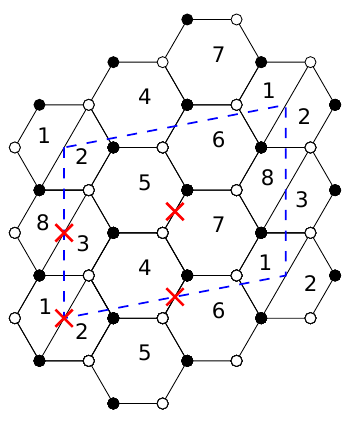
Figure 12 . PdP 5 0